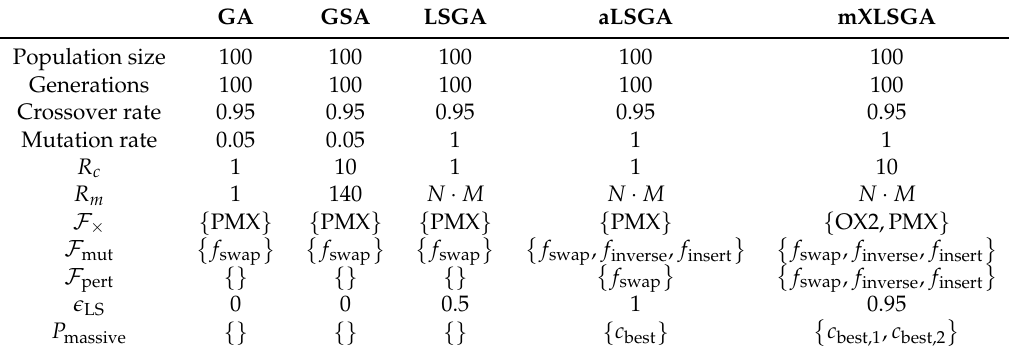
Table 6. Set up for case study III. Where c best is the best individual in the population and c best,1 and c best,2 are the two best individuals in the population who are